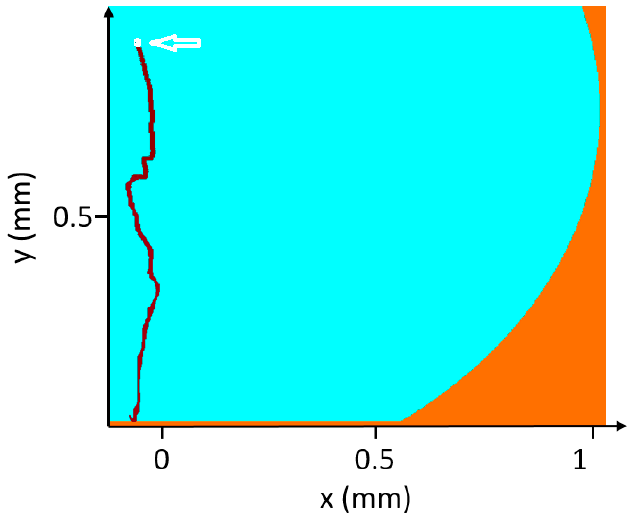
Figure 4. Trajectory of a large polystyrene particle in the convective flow field in the drop.